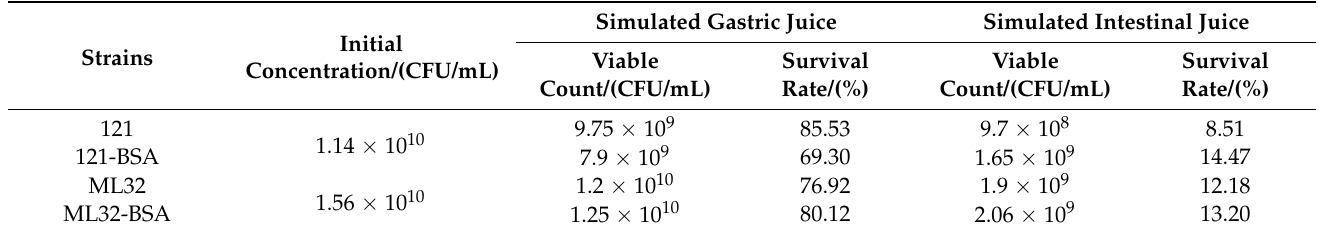
Table 1. The survival rate of strains in the simulated gastrointestinal tract in the presence of BSA.